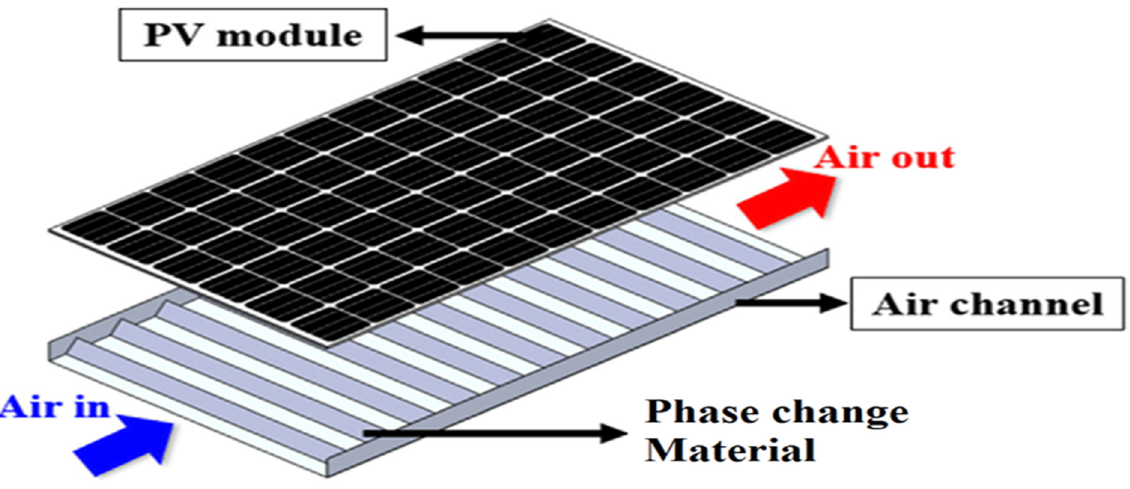
Figure 4. Diagram of an air-based hybrid PVT/PCM system.